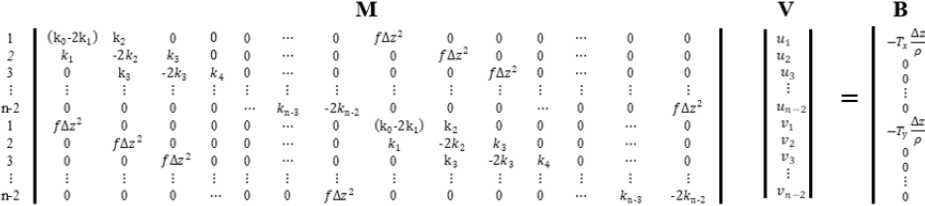
Figure 3. System of equations, iterations from i = 1 to i = n − 2 that are represented by the following matrices: M, coefficient matrix; V, matrix of velocity vectors u and v for the n − 2 water layers that make up the depth gradient column ∆ z ; B, resulting from the n − 2 algebraic expressions.